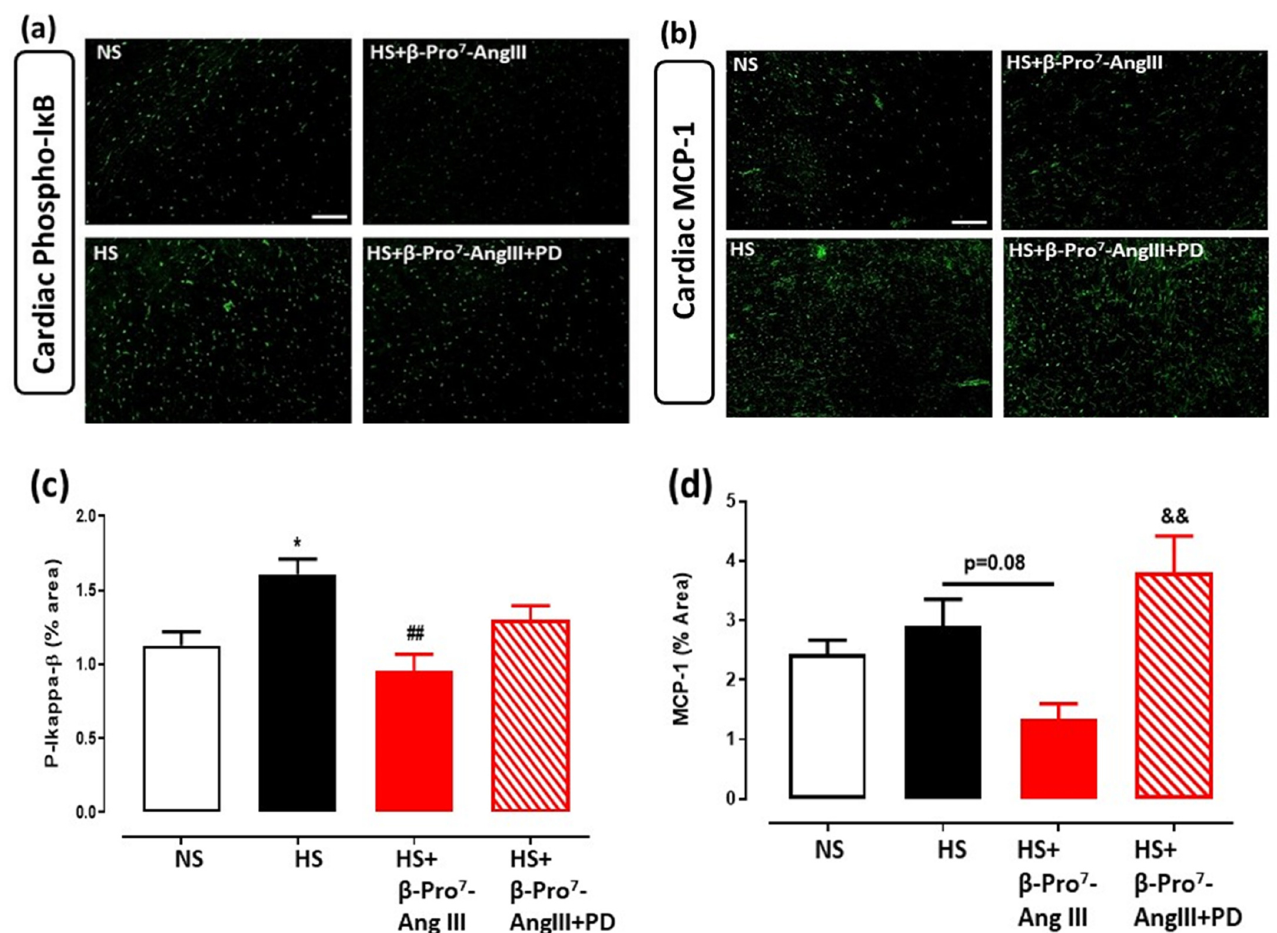
Figure 5. Representative images for ( a ) p-I κ B and ( b ) MCP-1 in LV sections obtained from male FVB/N mice fed on a normal salt (NS, 0.5% NaCl) diet or mice fed on a high salt (HS, 5% NaCl) diet in the presence or absence of β -Pro 7 -AngIII (0.1 mg/kg/day) +/ − PD123319 (1 mg/kg/day). Scale bar for all images = 50 μ m. Group data of % area of ( c ) p-I κ B and ( d ) MCP-1 in LV sections from indicated groups (n = 4–6 per group). All data are expressed as mean ± s.e.m. * p < 0.05 vs. sham; ## p < 0.01 vs. HS; && p < 0.01 vs. HS+ β -Pro 7 -AngIII, determined by One-Way ANOVA with Tukey correction for multiple comparisons.